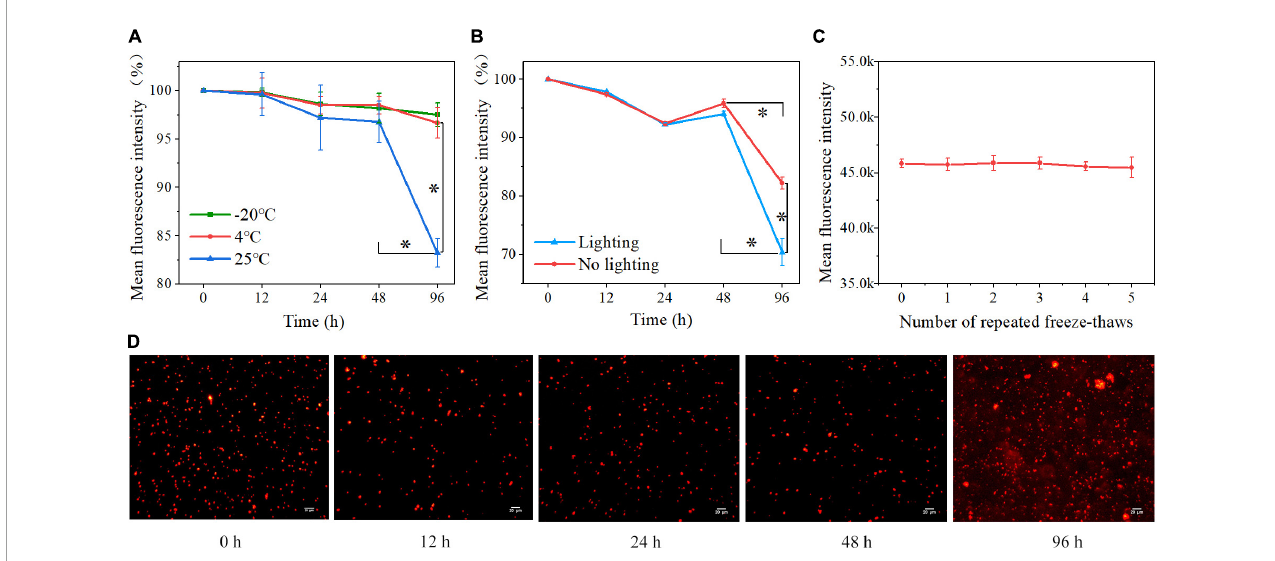
FIGURE4 (A) Percentage loss of Cy5.5@S. aureus fluorescence signal over 96 h in light-protected storage at different temperatures (B) and under different light conditions at 25 ◦ C. The fluorescence intensity of Cy5.5@S. aureus stored for 0 h was 100%. (C) Effect of repeated freeze-thawing (5 times) on the fluorescence intensity of Cy5.5@S. aureus . (D) Fluorescence micrographs of Cy5.5@S. aureus at various time points during storage at 25 ◦ C for 96 h, with Cy5.5@S. aureus shown in red (scale bar: 20 µ m, exposure time: 300 ms). Data are displayed as mean ± SD. * P < 0.01. N = 3 in each